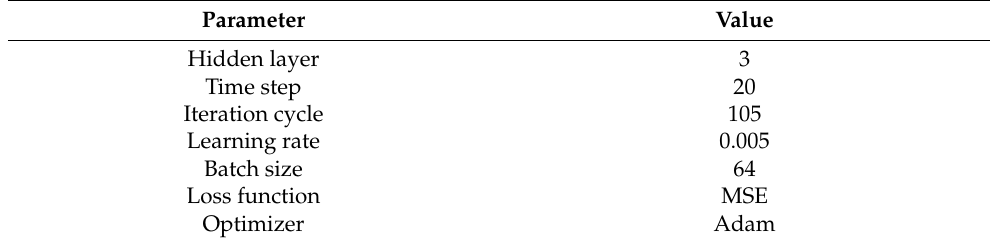
Table 1. The hyperparameters of the LSTM model. Parameter Value Hidden layer 3 Time step 20 Iteration cycle 105 Learning rate